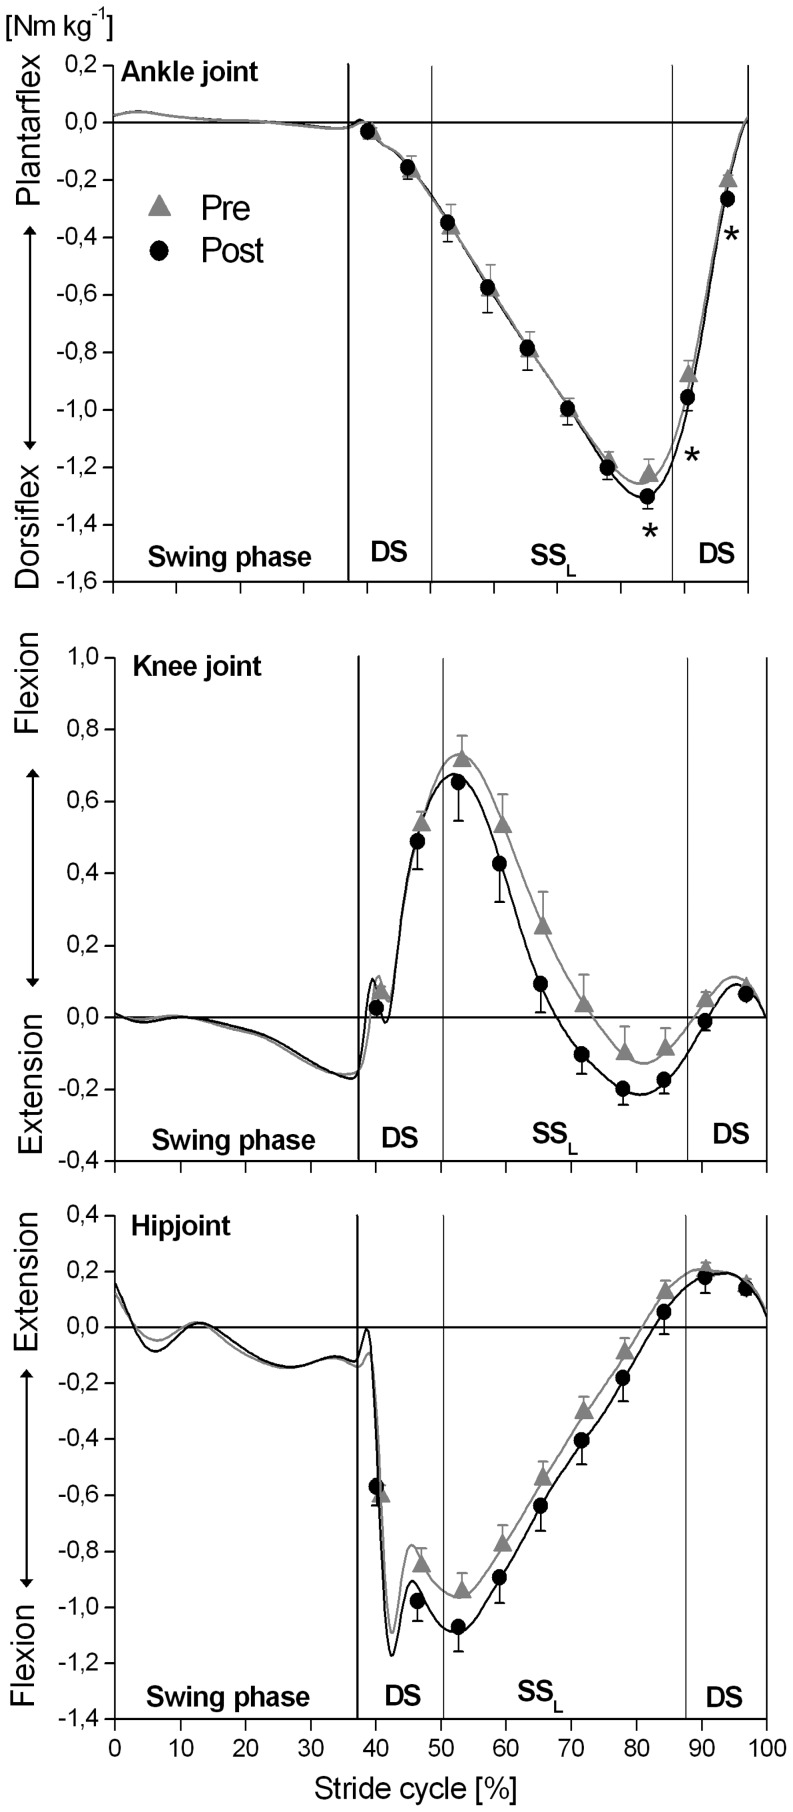
External joint moments at the ankle, knee and hip in the sagittal plane at different phases of the ground contact phase while incline walking determined before (pre) and after (post) the triceps surae and quadriceps femoris muscle-tendon unit exercise-intervention (means and SE).The x-axis was normalized from 0 to 100% of a stride cycle. The vertical solid lines represent the instants of touchdown (TD) and take off (TO) of the left and right foot. DS: double support phase; SSL: single support phase of the analyzed left leg. *: Statistically significant differences between pre and post (P<0.05).